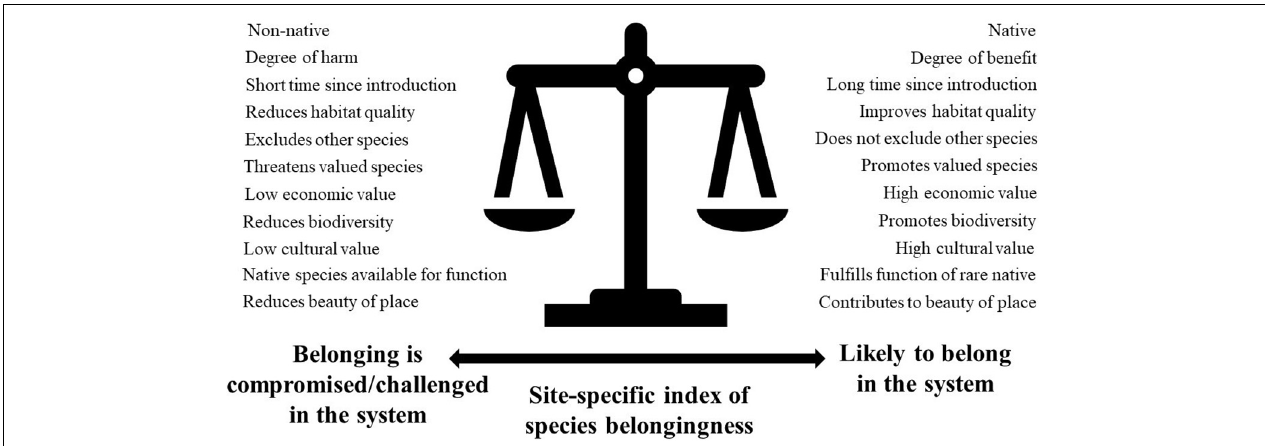
FIGURE 2 | A new conceptual model for determining the viability of a non-native species in a given area. The criteria presented here are not absolutes but can be modified depending on circumstances. The end result would be a score analogous to a weed risk assessment.